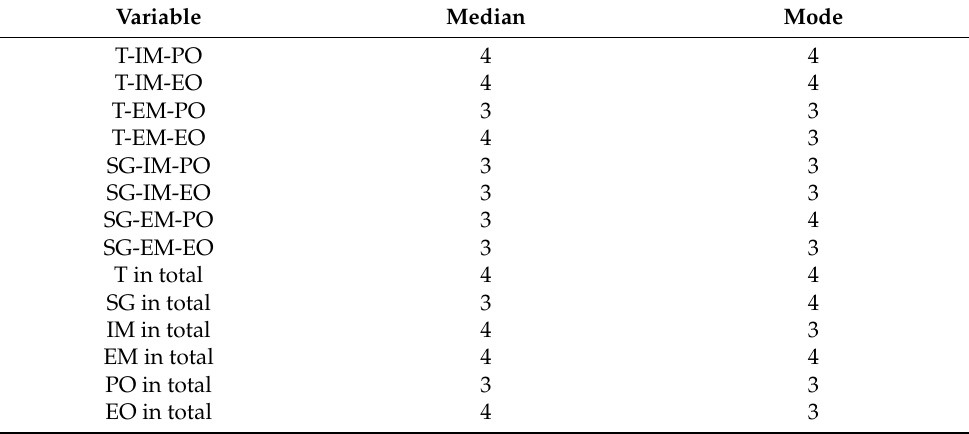
Table 4. Vignette assessments: mode and median (individual and isolated per